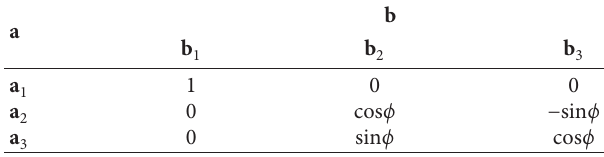
Table 3: Coordinate system transformation between a and b .